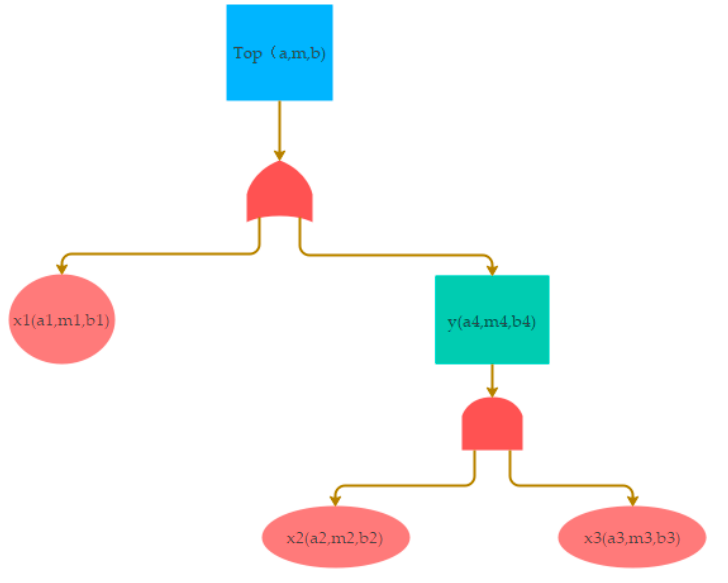
Figure 9. Friction torque fault tree.